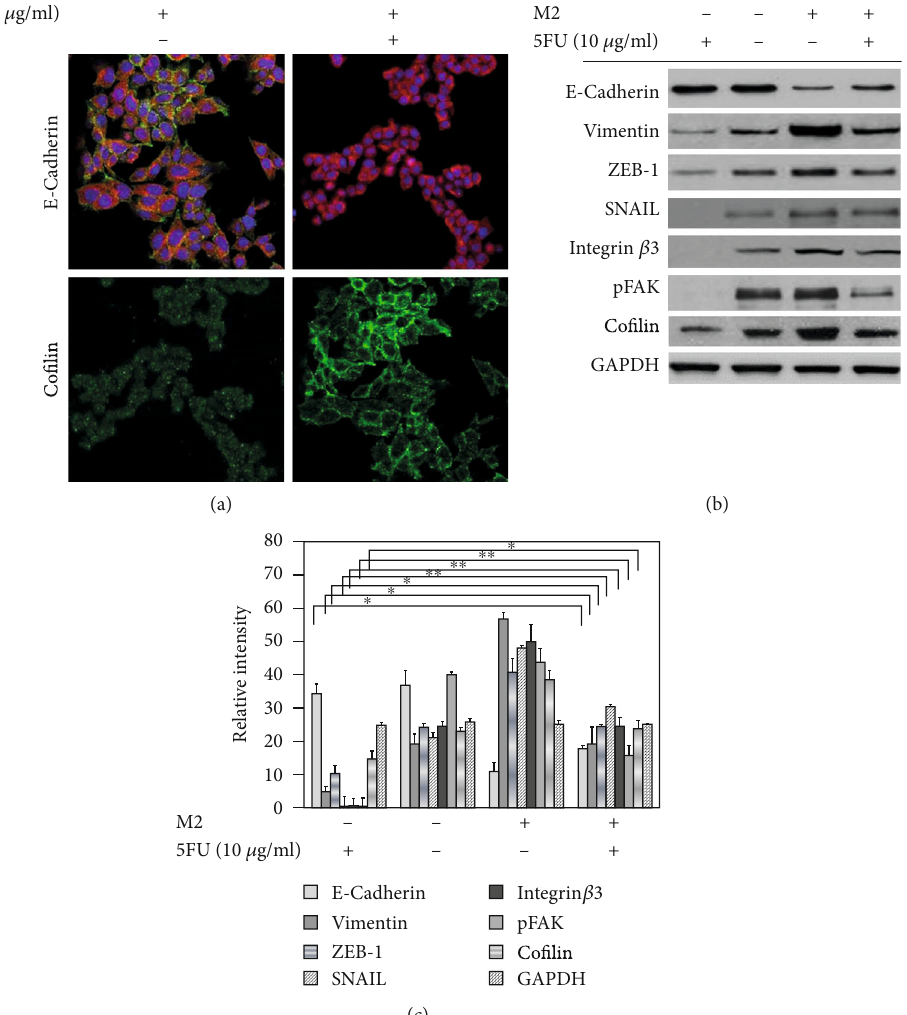
Figure 5: (a) E-cadherin and co fi lin expression in AGS. AGS cells were plated in 6-well plates containing cover glass for 24 h. After 24h of incubation, AGS cells were treated with 10 μ g/ml of 5FU and the inserts containing polarized THP-1-M2 macrophages were added to the AGS wells. AGS cells were then stained with DAPI and with E-cadherin, β -actin, and co fi lin antibodies. The stained cells were observed under a confocal microscope. (b) Western blot analysis of EMT factors. Western blot analysis of E-cadherin, vimentin, ZEB-1, Snail, integrin β 3, pFAK, and co fi lin expression. (c) Quanti fi cation of western blot bands. Statistically signi fi cant di ff erence was set at ∗ P < 0 : 05 , ∗∗ P < 0 : 01